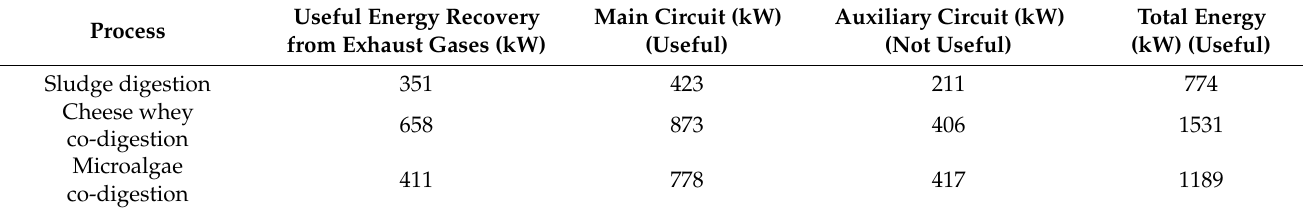
Table 10. Results from the cooling circuit energy balance. Quantities refer to thermal power having application in other uses. The low temperature of the auxiliary circuit stream makes its application unfeasible at the current WWTP configuration (losses in plate and exhaust gas heat exchangers were not taken into account for the sake of simplicity).